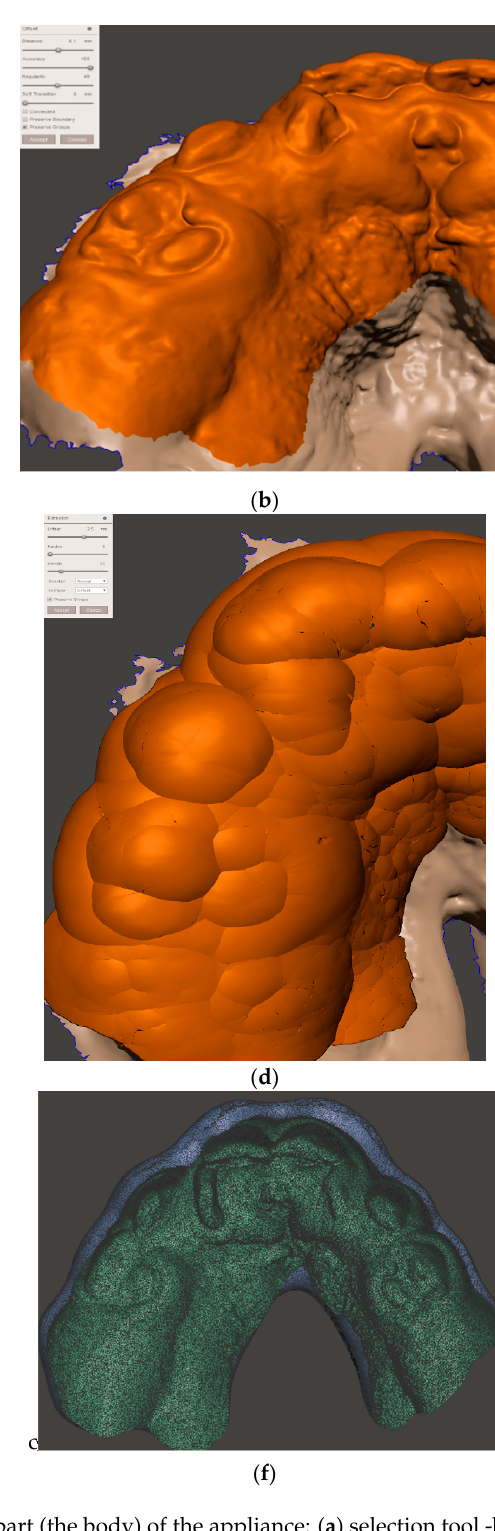
Figure 9. Steps to create the Alveolar part (the body) of the appliance: ( a ) selection tool -boundaries definition. ( b ) Select tool, -> optimize boundaries—keystrokes “O”, “B”; ( c ) Edit—Offset tool by 0,1 mm creating a separated copy of the morphology; ( d ) Edit—Extrusion keystroke “D” direction “normal”; ( e ) automatic: Select group and keystroke “Ctrl+F” smooth or Manual: Sculpt—Surface brush—“Robust smooth”—filters “restrict to group”; ( f ) Final 3D Alveolar body of